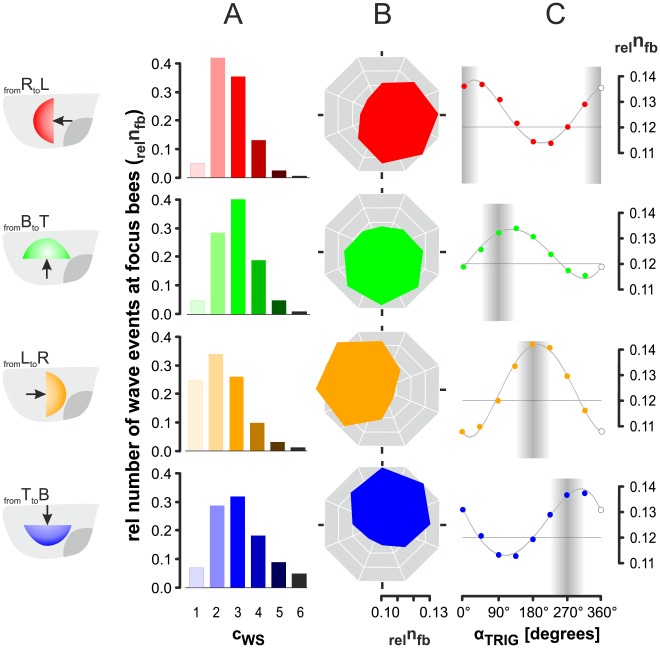
Correspondence of trigger direction and wave direction in individual focus bees addressing linearity of wave spreading in shimmering.The ordinates show the rate of wave incidents assessed at individual focus bees (relnfb) and normalized for the maximum number of incidents per wave direction (relnfb = 1 for MAX nfb [dirWAV]). (A) Distribution of wave incidents regarding the four wave directions (dirWAV = 1–4). The focus bees were distinguished according to their individual wave strength levels (cws = 1–6) in different colours; for evaluation, only those focus bees were selected that had been triggered by an immediate neighbour in the near neighbourhood (radiusNh<40 mm); red, from Right to Left (fromRtoL), n = 2825 wave incidents; green, from Bottom to Top (fromBtoT), n = 2908; orange, from Left to Right (fromLtoR), n = 2433; blue, from Top to Bottom (fromTtoB), n = 1256. (B-C) distributions of wave events regarding the trigger directions of individual focus bees (dirTRIG = 1–8; for definition, see Table 1). Angular sector lines in (B) and abscissa in (C) show the trigger angle αTRIG. (C) The curves show the regression polynomials (for specification see Table 2); the grey vertical bars refer to the main wave directions coded by the median as αWAV (dark grey) and the tolerances of ± 45° (bright grey).